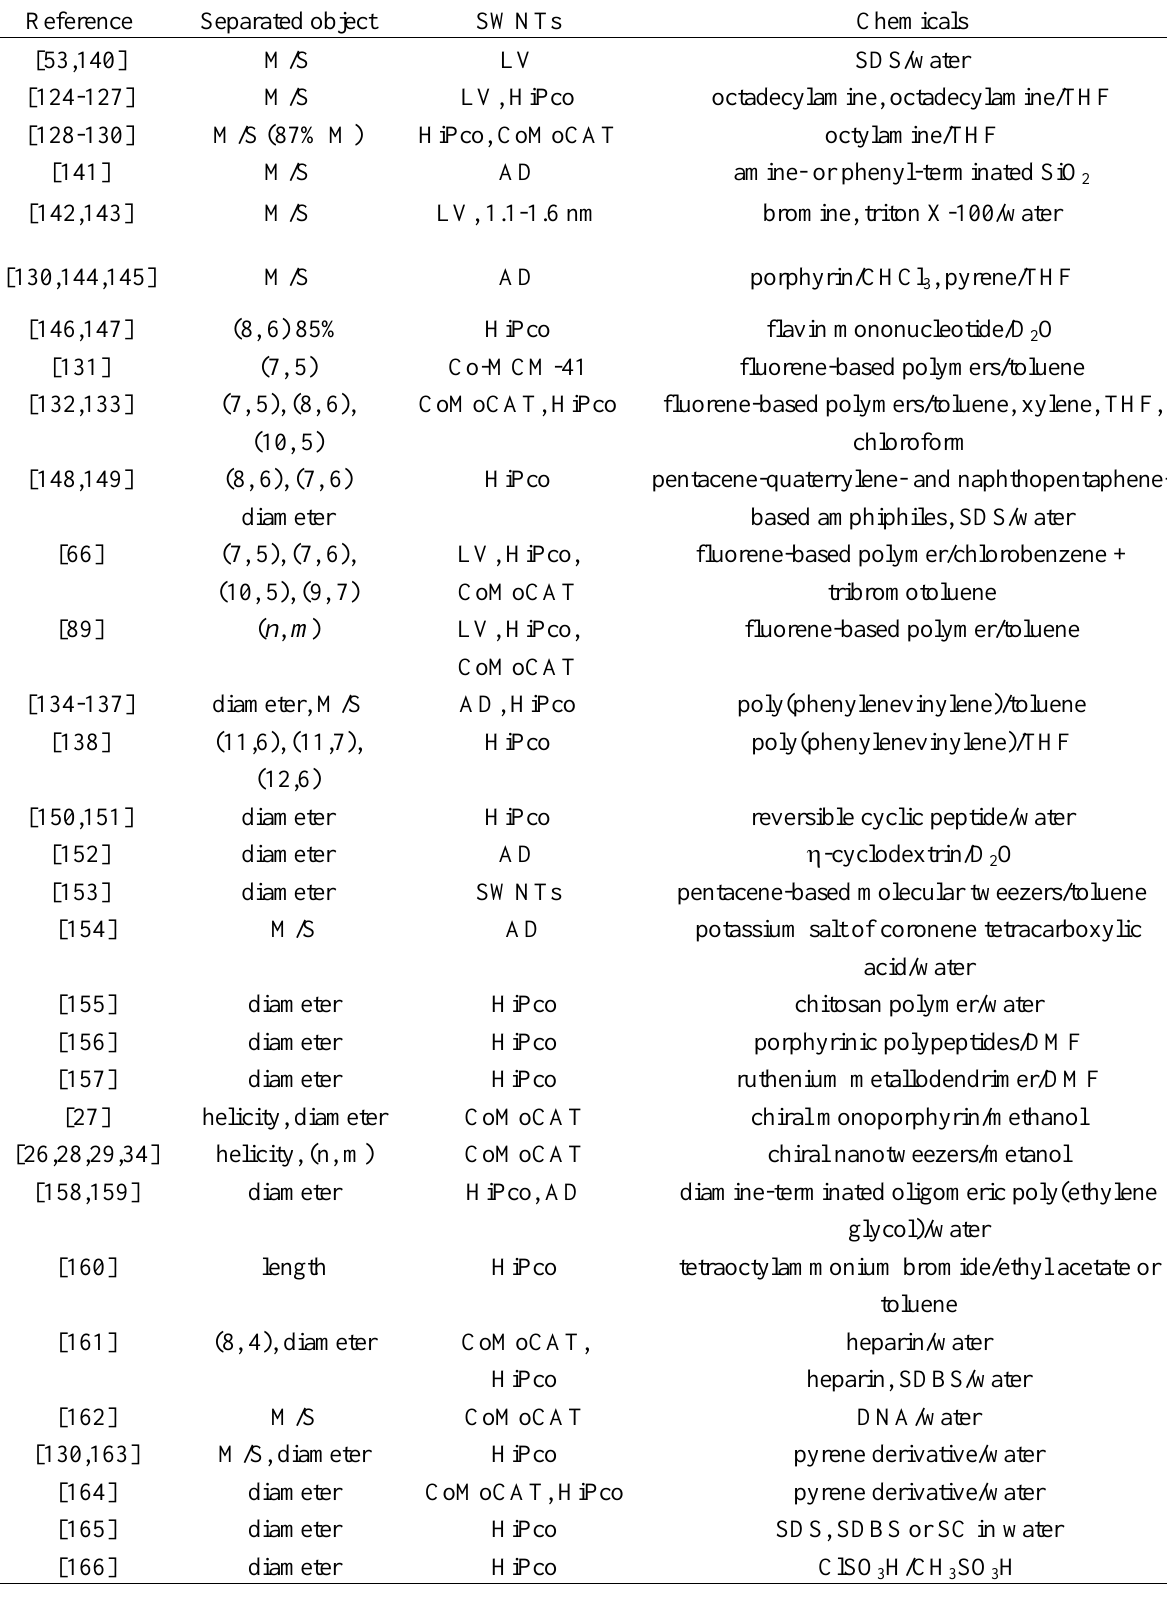
Table 4. Separation of SWNTs by selective